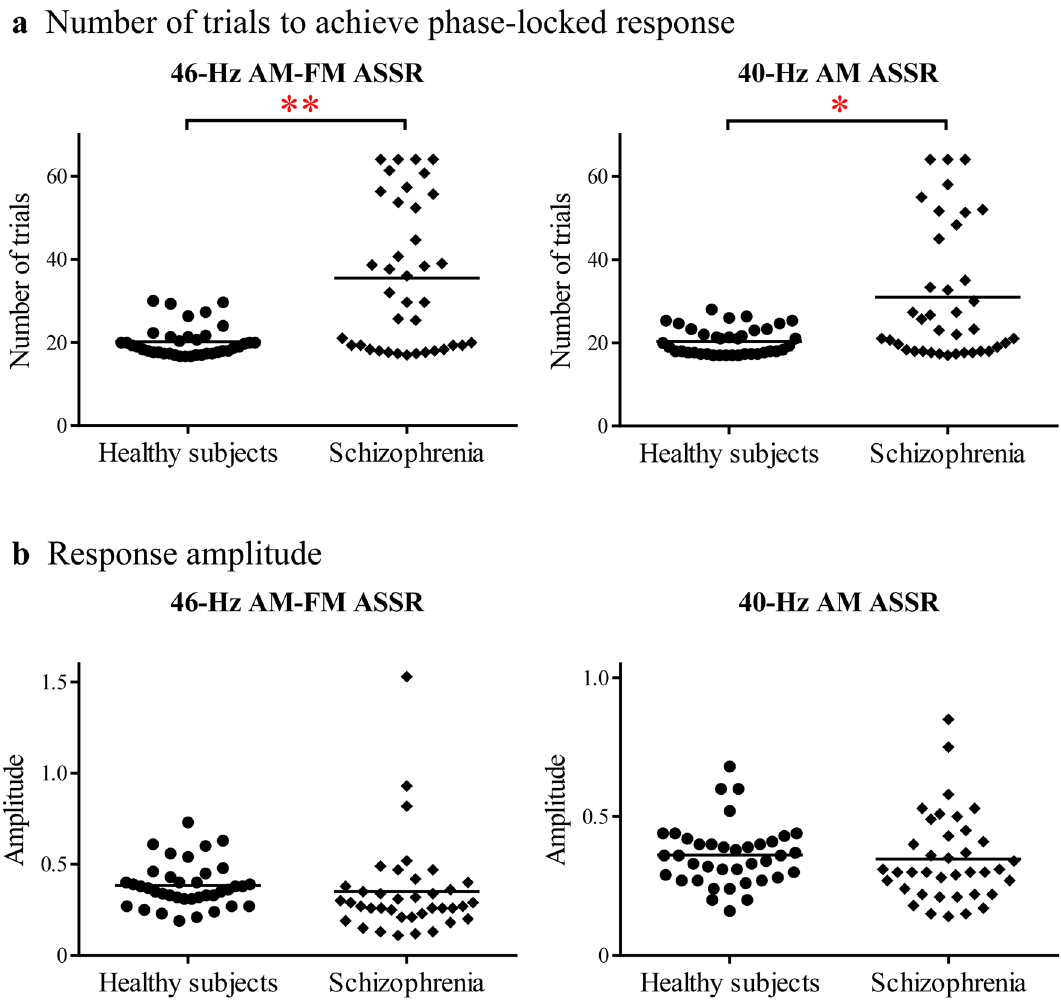
Figure 2. Trends to achieve the phase-locked response and the ASSR potentials. ( a ) Significant differences were observed in the number of trials conducted to achieve a phase-locked response between patients with schizophrenia and healthy subjects in 46-Hz AM-FM ASSR ( left ) and 40-Hz AM ASSR ( right ) . ** P < 0.0001, * P = 0.0001. ( b ) No significant differences were observed between patients with schizophrenia and healthy subjects in terms of the response amplitudes of 46-Hz AM-FM ASSR ( left ) and 40-Hz AM ASSR ( right ). Number of trials to achieve the phase- locked